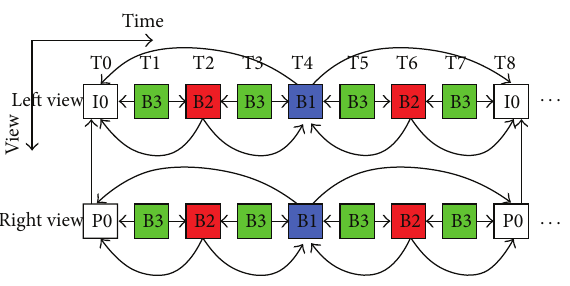
Figure 2: HBP coding structure of left view and right